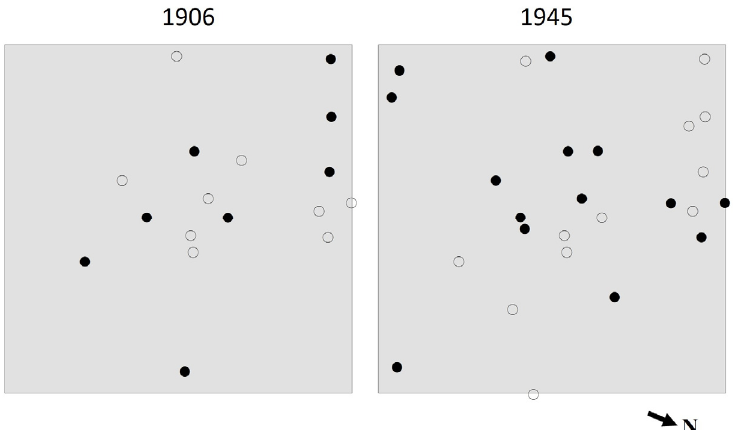
Figure 7. Stem maps of a 1 ha plot showing the position of present day canopy Quercus trees that were at least 10 years of age in 1906 and 1945, respectively. Solid dots indicate stems experiencing release in the respective year, open dots indicate stems not experiencing release in the respective